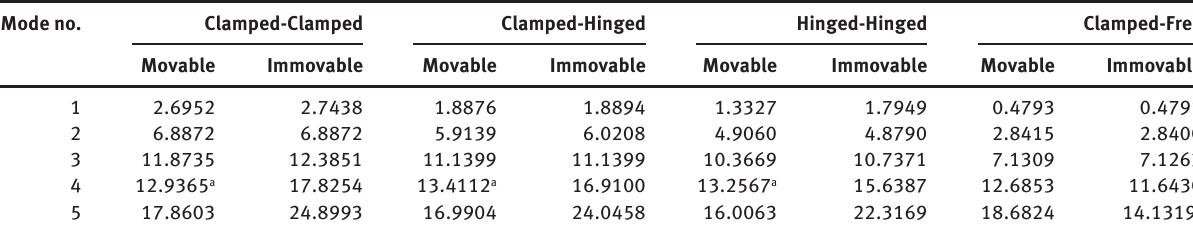
a Indicating the longitudinal vibration mode.